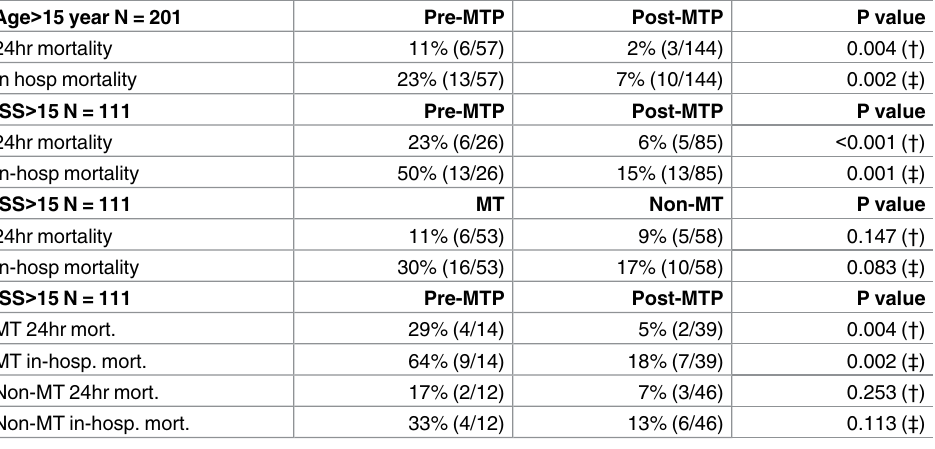
Table 2. Effect of additional selection criteria on mortality statistics.